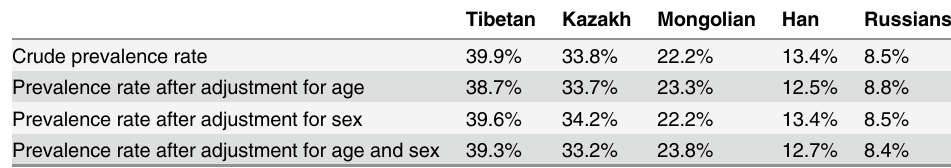
Table 2. The prevalence rate in different ethnical